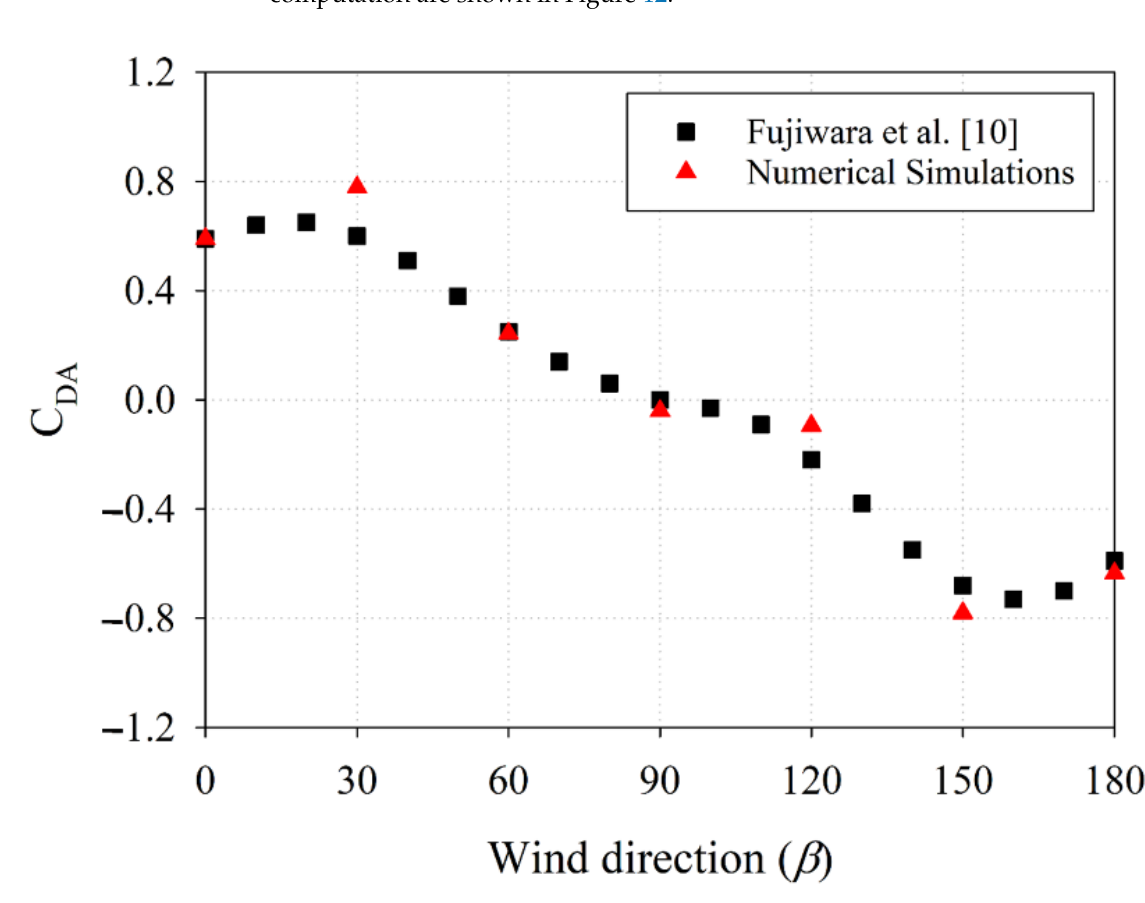
Figure 11. Comparison of wind force coefficient obtained by CFD computations and Fujiwara regression method [10]. Source: Own elaboration.